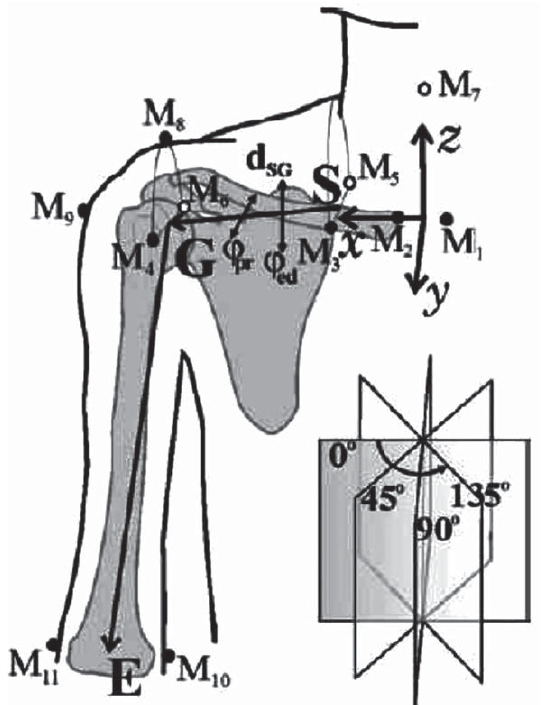
Fig. 5. Reference frame, sensor placement locations and four planes of elevation used in